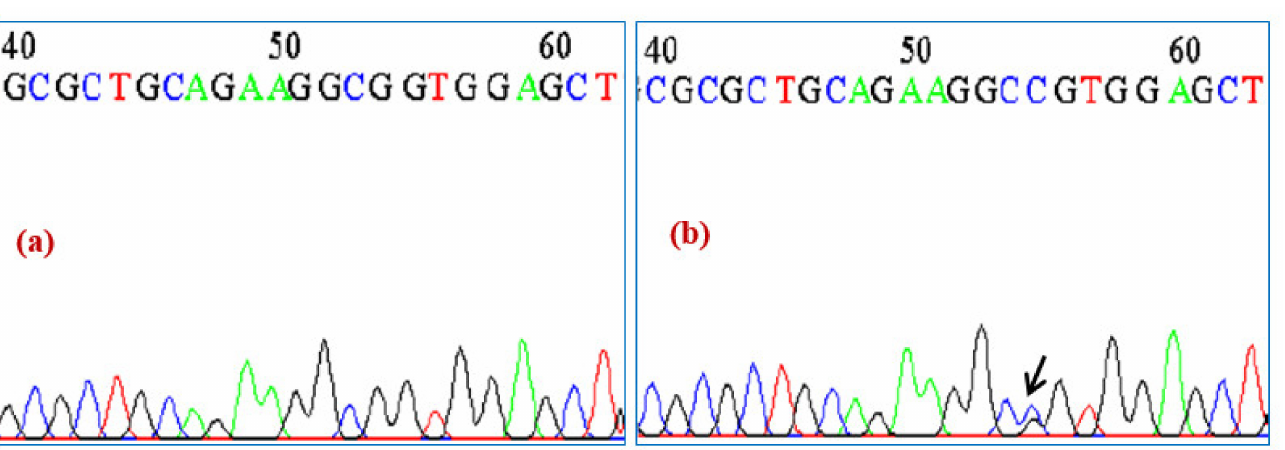
Figure 2. ( a , b ) The chromatogram of exon 1 of ACTC1 gene. However, a novel nucleotide variation leading to G > C transversion was observed in exon 2 in one of the blood samples of CCSD patient. The change lies in the coding region of exon 2, which changes codon GCG > GCC (Figure 3).